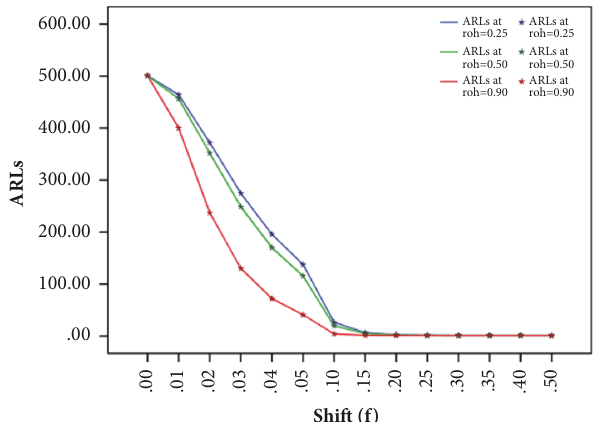
Figure 2: ARLs for proposed repetitive EWMA-RSS control chart using Bahl and Tuteja (1991) ratio estimator, when 𝑟 𝑜 = 500 at 𝜆 = 0.2.